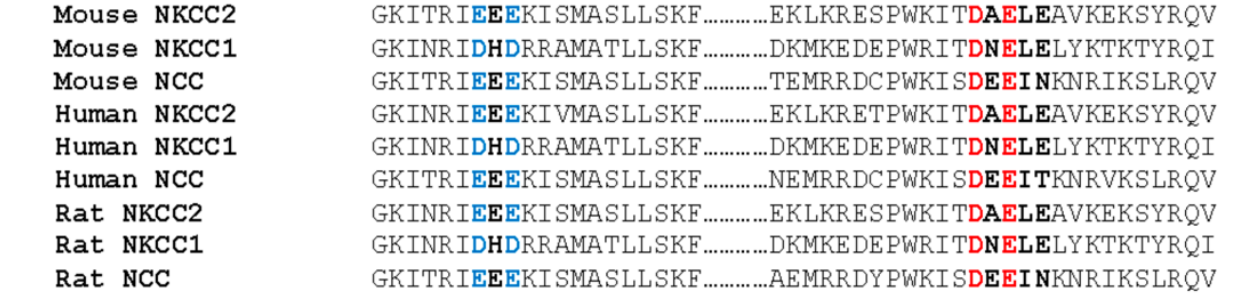
Figure 7. D 1019 and E 1021 of the 1019 DAE 1021 motif are conserved. Amino acid sequence alignment of the carboxyl termini of the structurally related Na-Cl cotransporters NKCC2, NKCC1 and NCC. The E 949 and E 951 residues of the 949 EEE 951 ( 949 EXE 951 ) motif are in blue. In red, the D 1019 and E 1021 residues of the 1019 DAE 1021 ( 1019 DXE 1021 ) motif. See “Results” for additional details.